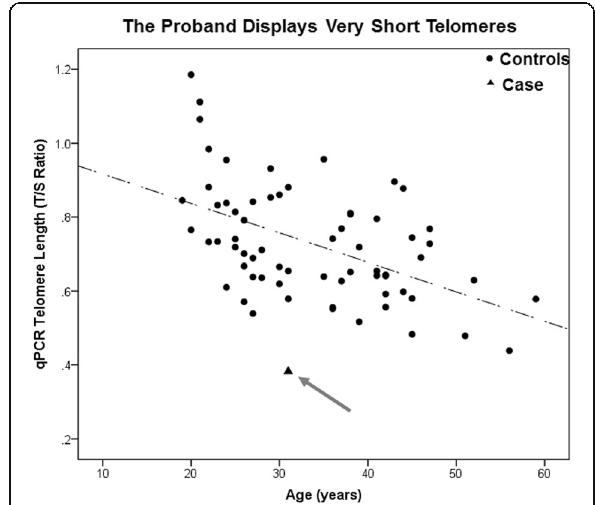
Fig. 3 Proband has short telomeres relative to age matched controls. qPCR telomere length assay was performed using genomic DNA as a template on the proband and 66 controls of variable ages. Telomere length is plotted versus age in years. ● = controls ▲ =proband, marked with an